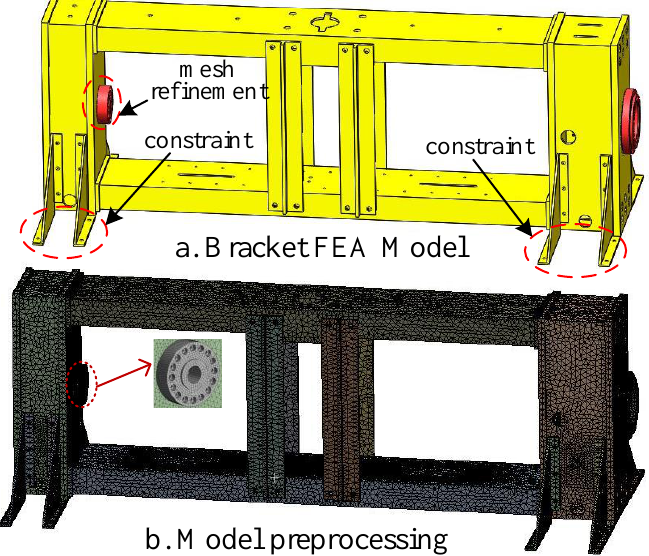
Figure 2. Finite element modeling and pre-processing: ( a ) bracket FEA model; ( b ) model prepro- cessing.